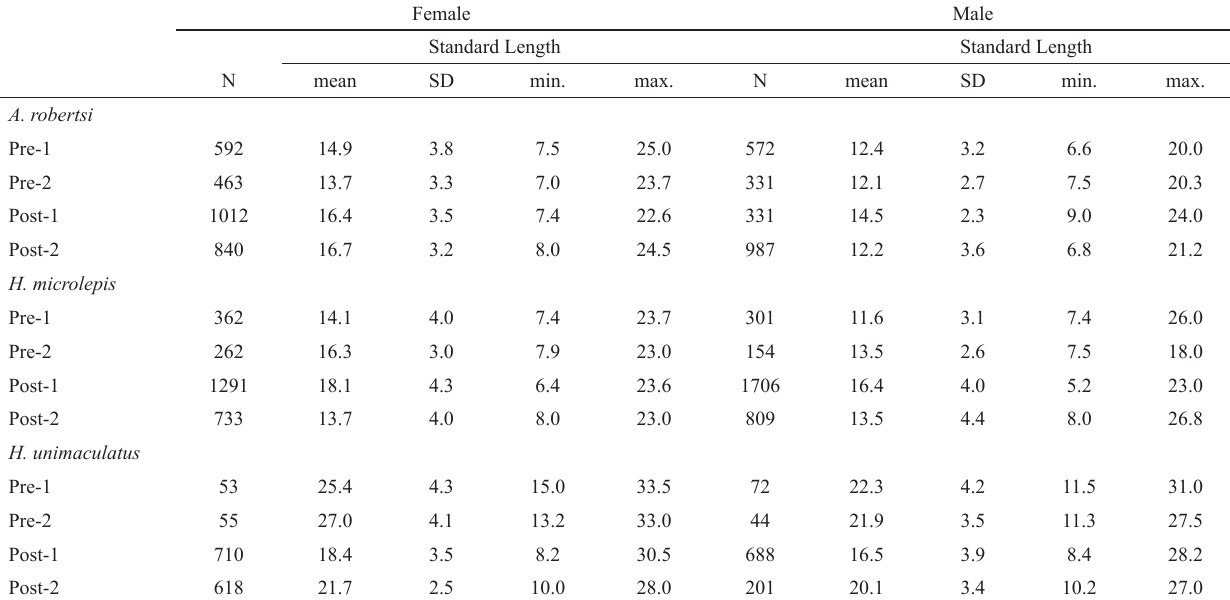
Table 2. Total fish captured (N) and length structure (standard length, cm) of H. unimaculatus , H. microlepis and A. robertsi before (Pre) and after (Post) the formation of Lajeado Reservoir. SD = standard